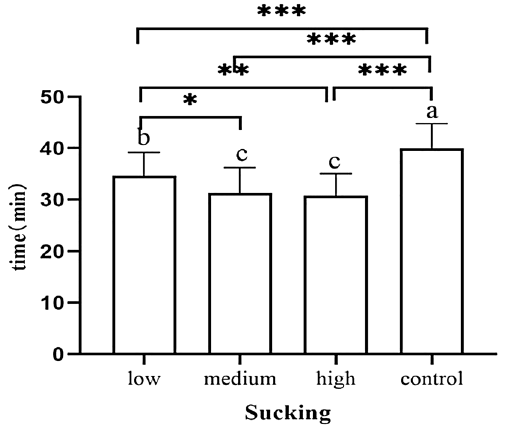
Figure 12. Duration of sucking stage.